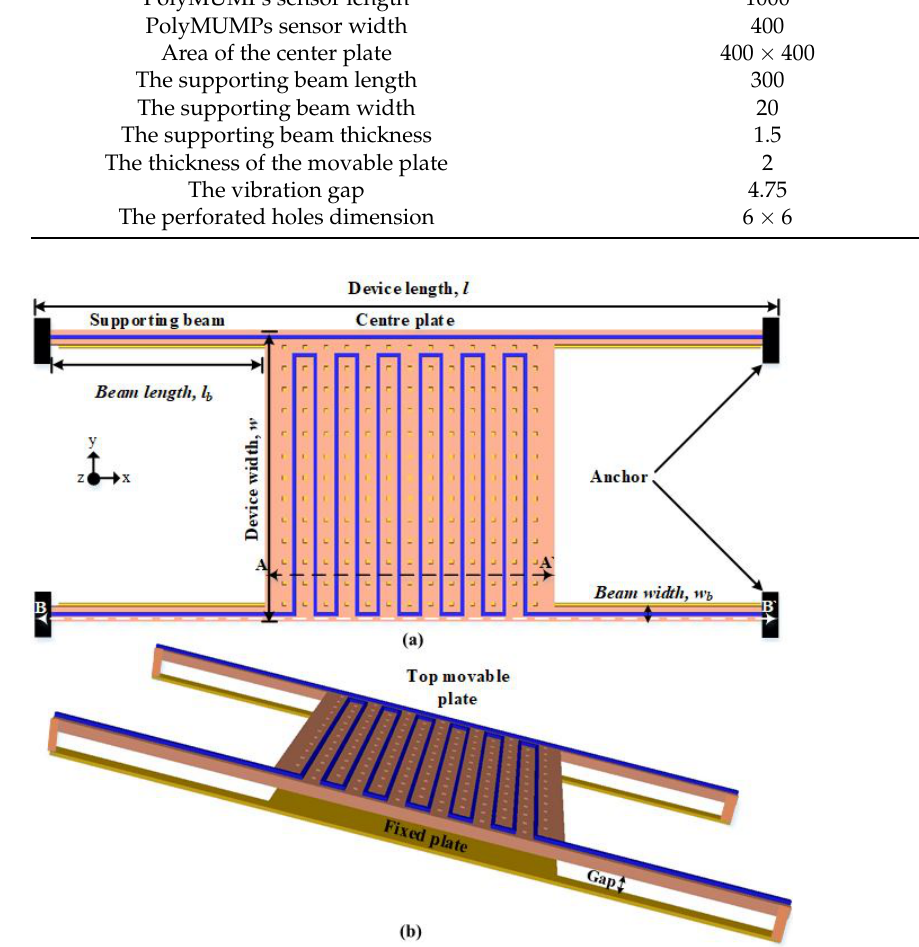
Figure 1. The PolyMUMPs sensor’s schematic showing ( a ) the top movable plate and ( b ) 3D schematic representation [18].